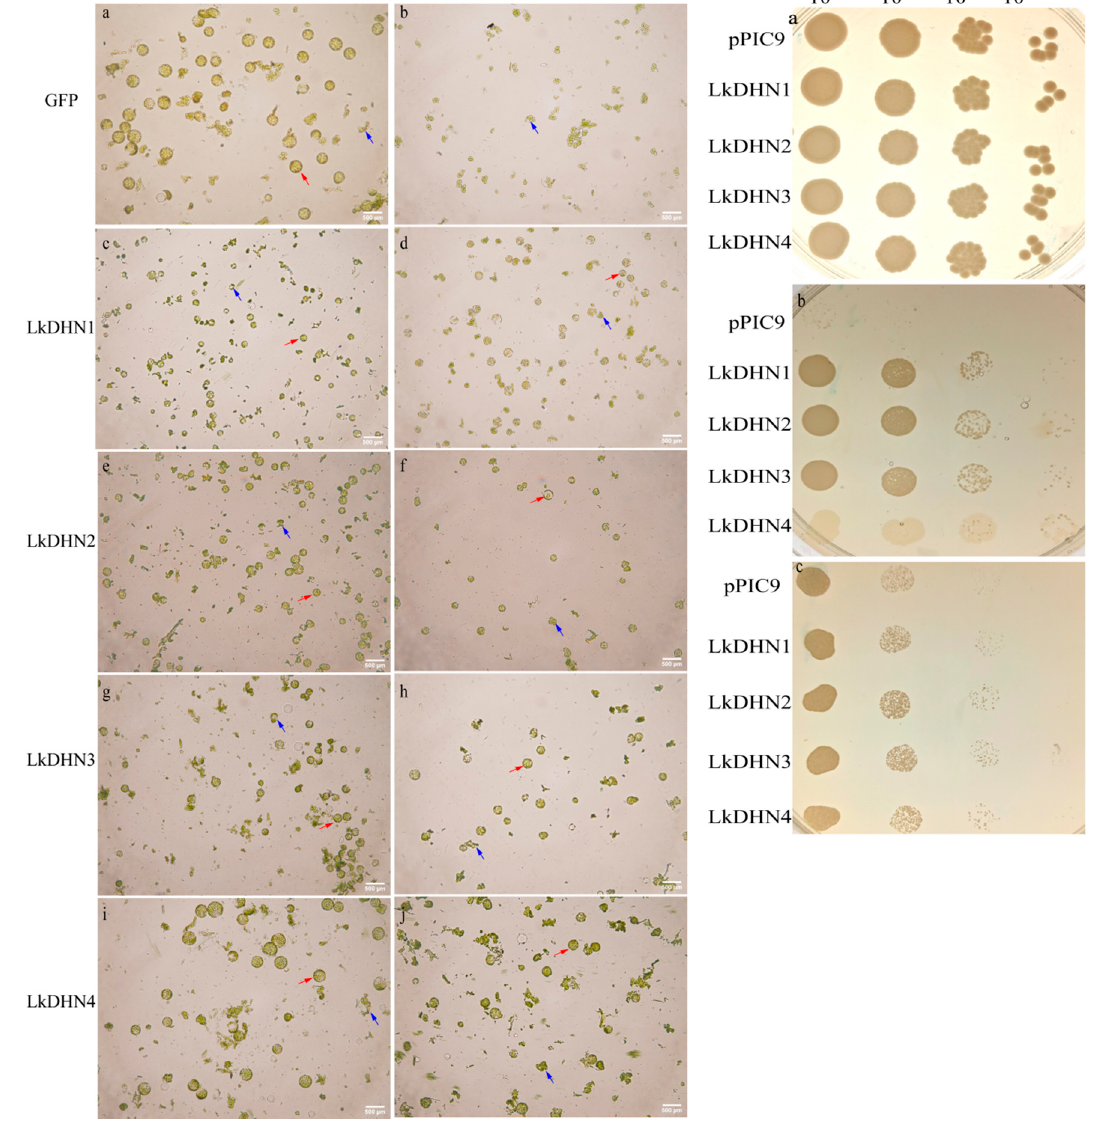
Figure 5. LkDHNs increased the tolerance of tobacco protoplasts and yeasts to osmotic stress. ( A ) The tolerance of tobacco protoplasts with LkDHNs to osmotic stress was enhanced. a and b are the enzymatic hydrolysis of GFP at 0.4 and 0.6 M mannitol, respectively; c and d are the enzymatic hydrolysis of LkDHN1 at 0.4 and 0.6 M mannitol, respectively; e and f are the enzymatic hydrolysis of LkDHN2 at 0.4 and 0.6 M mannitol, respectively; g and h are the enzymatic hydrolysis of LkDHN3 at 0.4 and 0.6 M mannitol, respectively; i and j are the enzymatic hydrolysis of LkDHN4 at 0.4 and 0.6 M mannitol, respectively. The intact protoplasts were indicated by red arrow; the broken protoplasts were indicated by blue arrow. The scale bar is 500 µ m. ( B ) Enhanced tolerance of yeast overexpressing LkDHNs to osmotic stress. a : spot assay of pPIC9 and LkDHNs on YPD medium; b : spot assay of pPIC9 and LkDHNs on YPD medium with 2 M sorbitol; c : spot assay of pPIC9 and LkDHNs on YPD medium with 1.5 M NaCl.